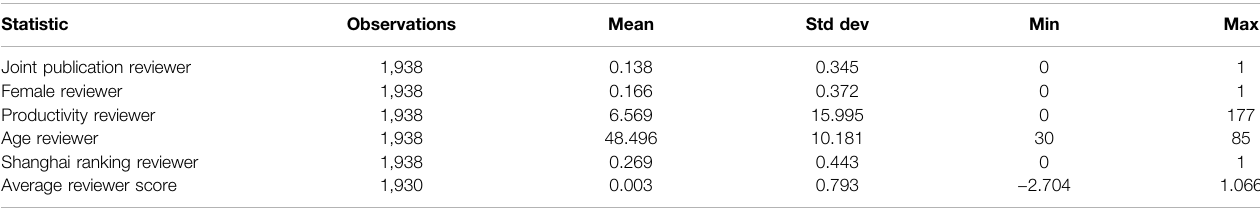
TABLE 6 | Descriptive statistics of external